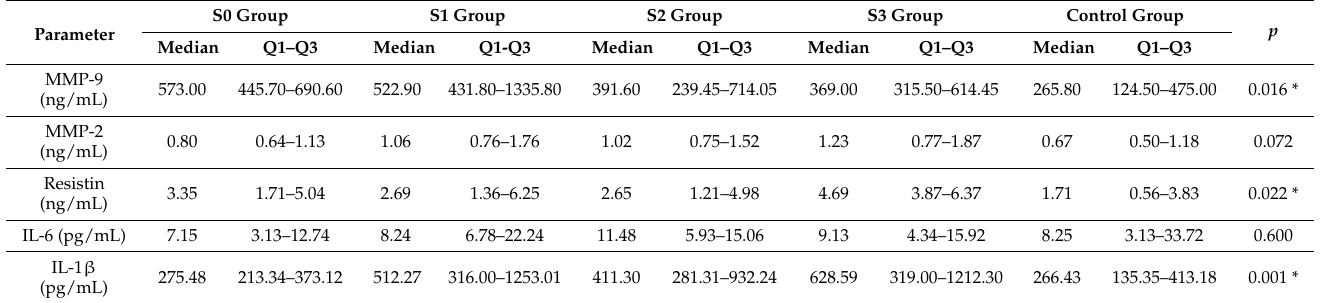
Figure 3. Percentage of people in individual groups who meet the norm for a given laboratory parameter. Table 5. Characteristics of the concentration of selected adipokines and pro-inflammatory cytokines in the unstimulated saliva of the study groups and the control